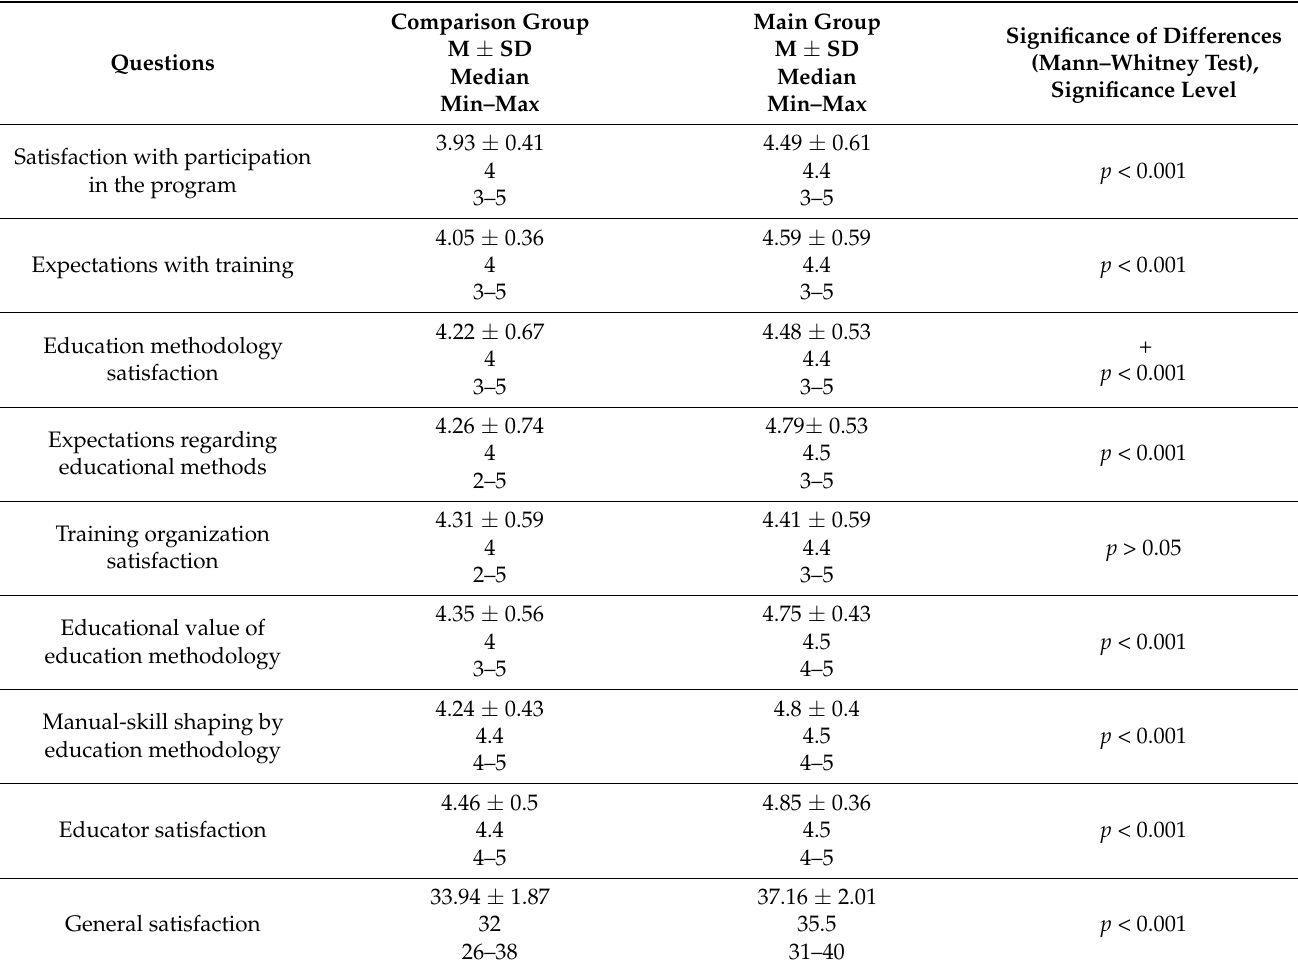
Table 3. Assessment of the level of satisfaction with training and its aspects in the two